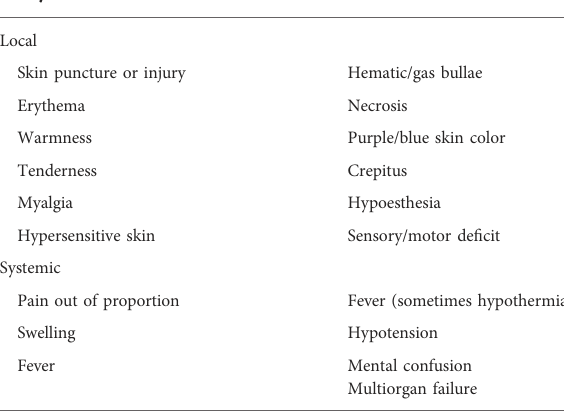
TABLE 1 Necrotizing fasciitis signs and